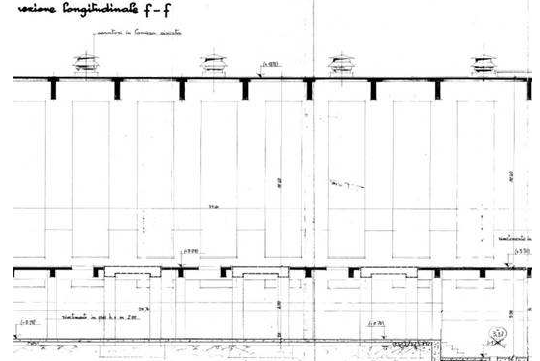
Figure 5. Longitudinal section of the old thermal power, coming from archival documents.